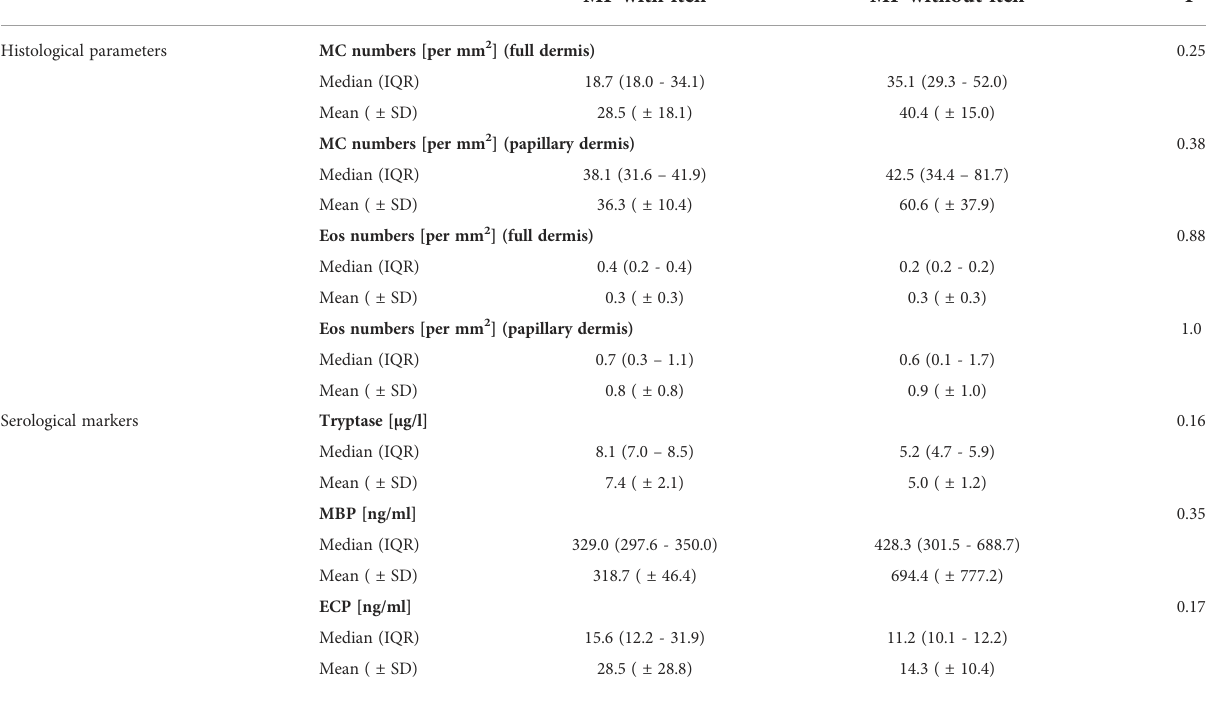
TABLE 2B Histological and serological differences of MF patients with and without itch. MF with itch MF without itch P